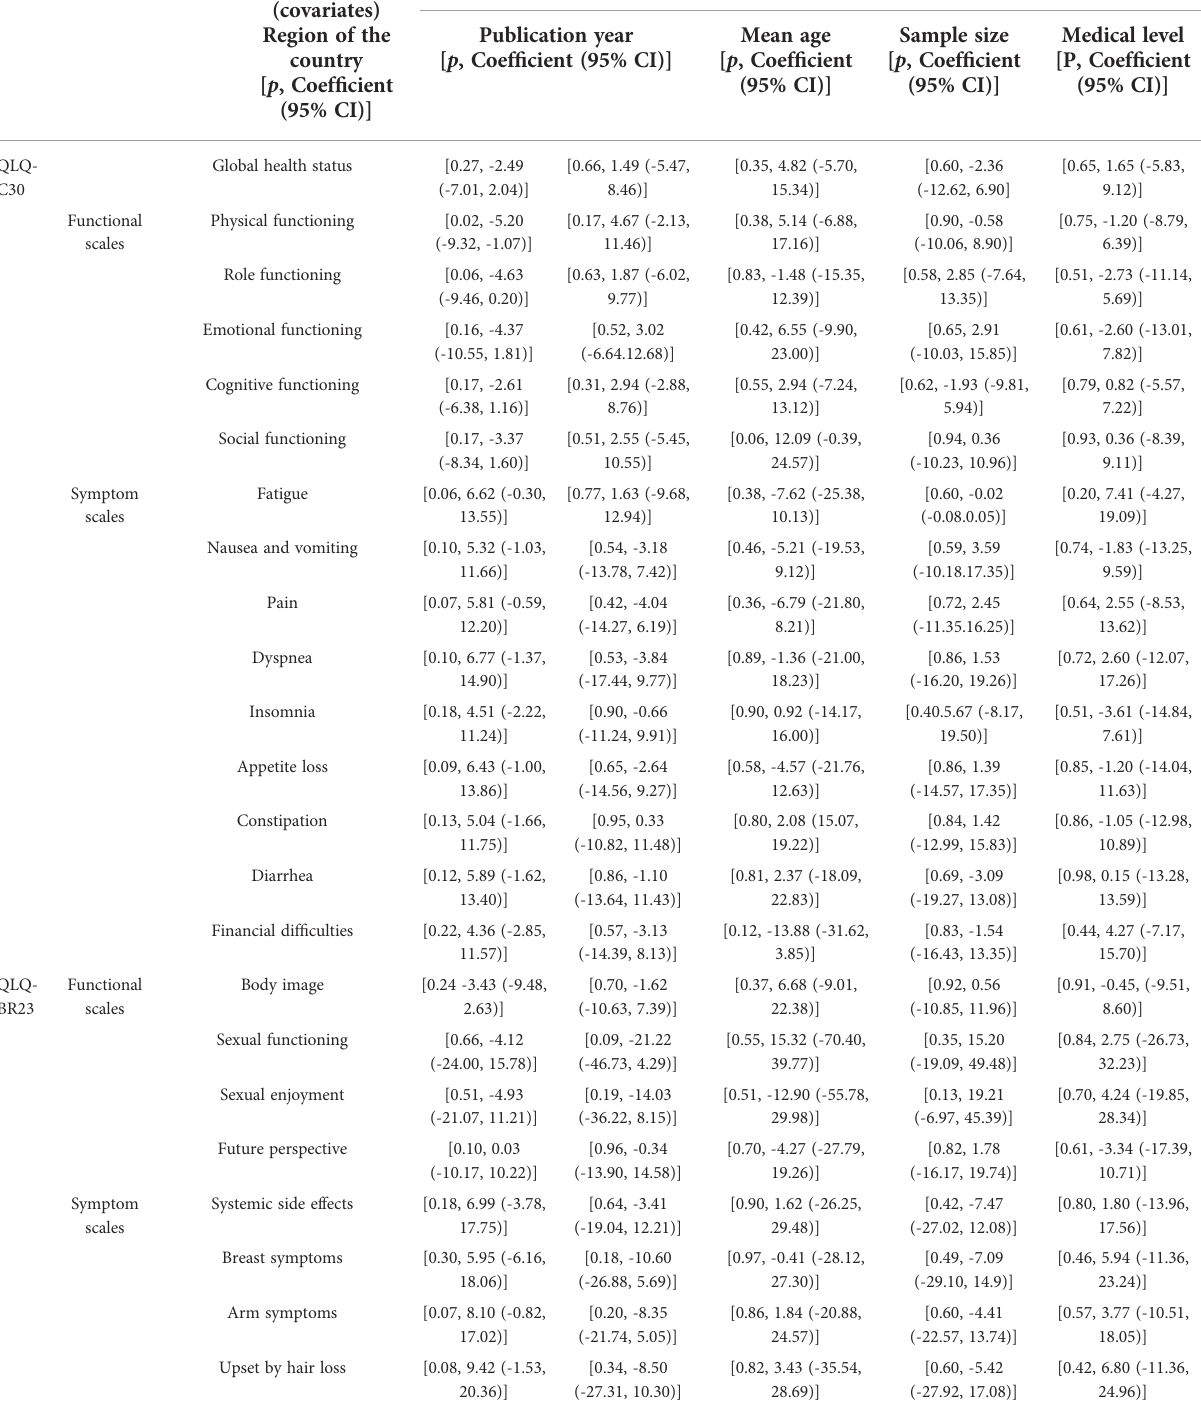
TABLE 6 Meta-regression